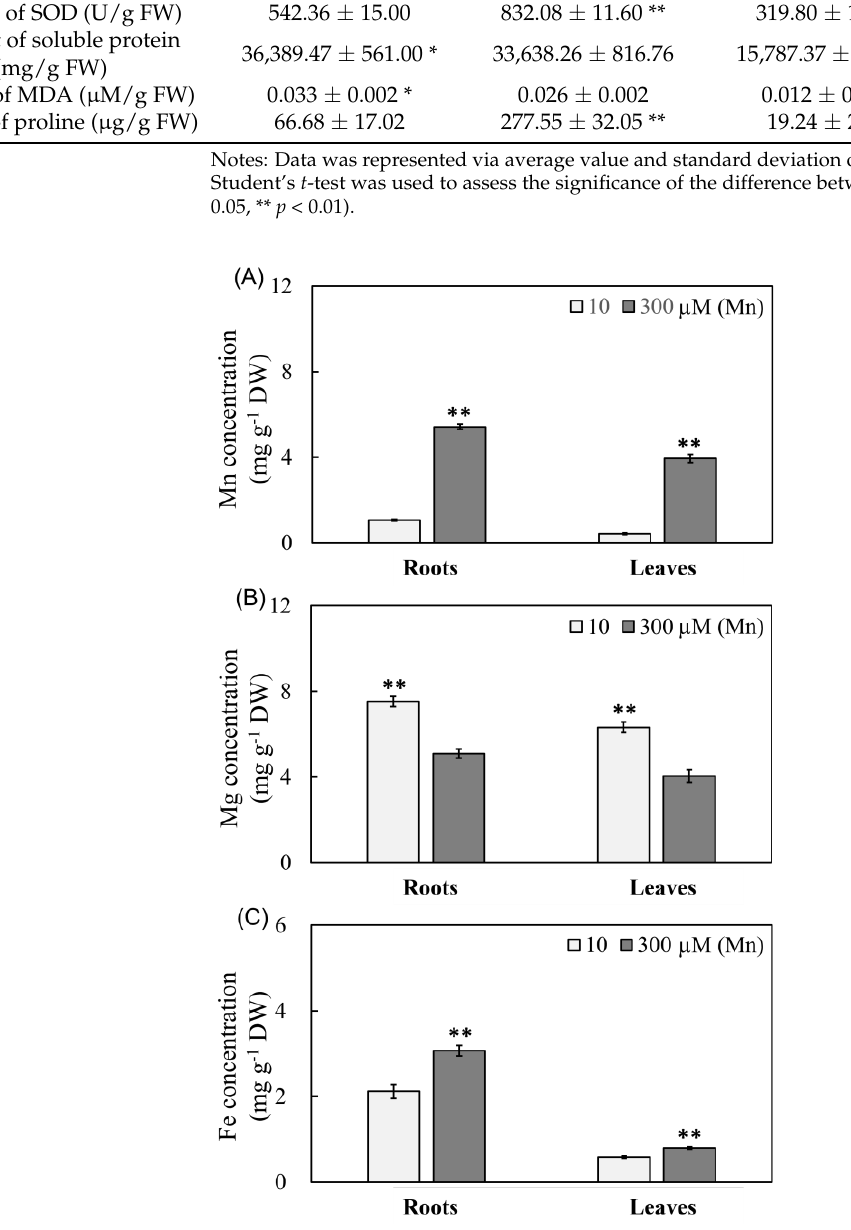
Figure 2. Results of varying Mn treatment concentrations on the Mn, Mg and Fe levels of peanut roots and leaves. ( A ) Mn content; ( B ) Mg content; and ( C ) Fe content. Data was represented via average value and standard deviation of four times experimental replications. Student’s t -test was used to assess the significance of the difference between the control and Mn toxicity (** p < 0.01).